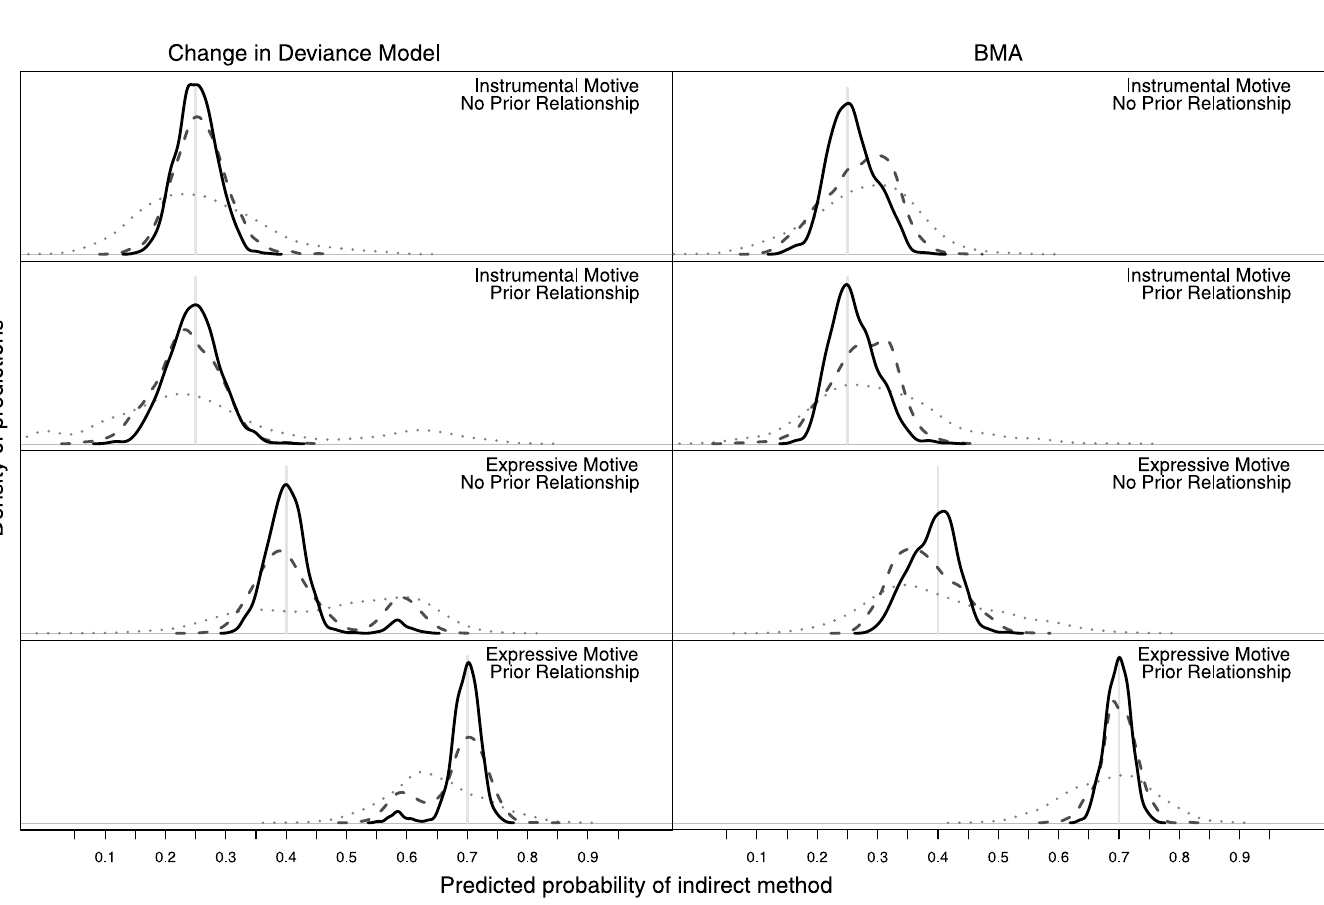
Fig 8. Density of predictions based on models using change in deviance (left) and BMA (right). Solid black line represents results N = 1000, medium grey dashed line N = 500, and light grey dotted line is N = 110. True population proportion indicated by grey vertical